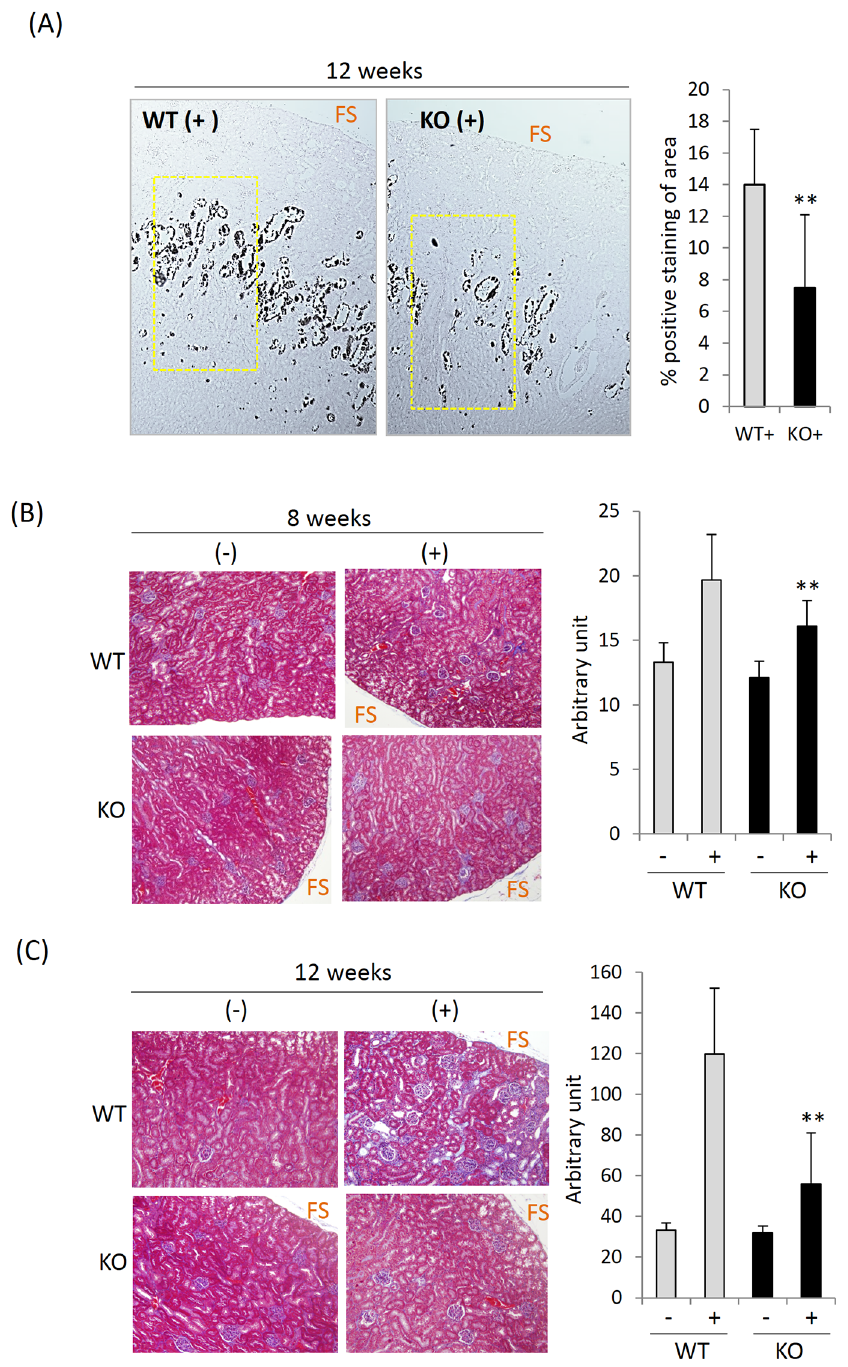
Fig 3. Collagen deposition by HPD is decreased by Pin1 deficiency. (A) Kidney sections from 12-week HPD (+) mice were stained with Von Kossa for calcium-phosphate containing salts (dark) and the positive area in outer medulla was quantified as shown and described in the Methods. (B) and (C) Kidney sections from 8 and 12-week control diet (-) and HPD (+) mice were stained with Masson ’ s trichrome (left) for total collagen deposition. The intensity of blue color was quantified and shown in bar graphs (right). FS: free surface of kidney. ** denotes p < 0.05 between genotypes by student's t-test with 6 mice each group.